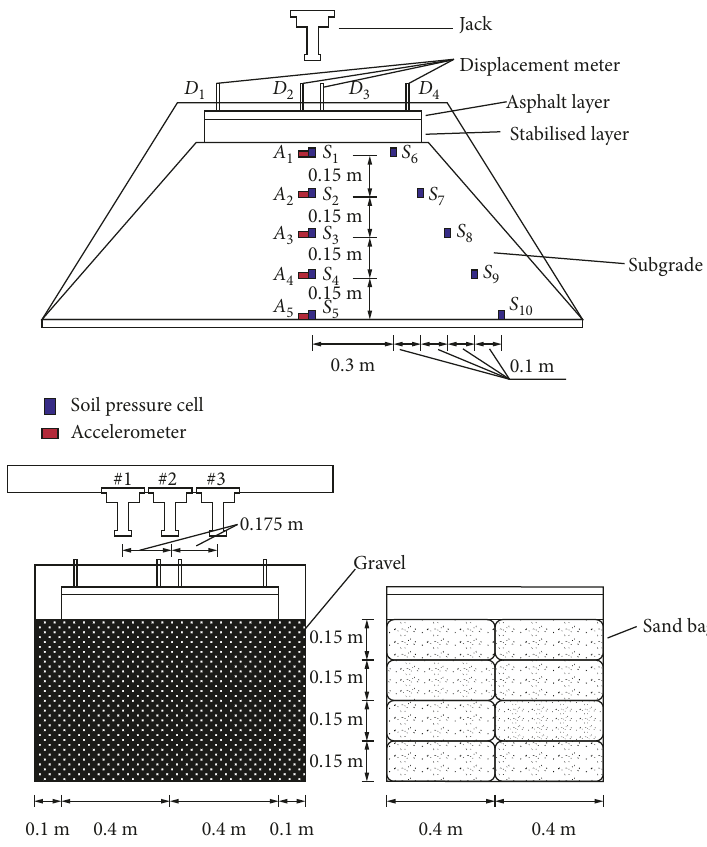
Figure 3: Model structures and layout of scaled